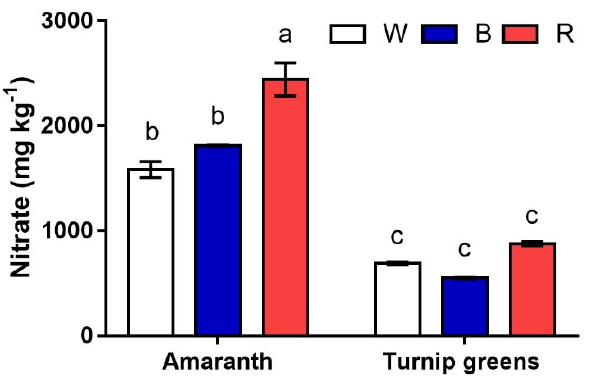
Figure 4. Interaction effect of species × light treatment (W = white, B = blue, R = red) on the nitrate content (ppm) of microgreens. Data are means ± standard error ( n = 3). Three biological replicates were used for the analysis. Different letters indicate significance at p ≤ 0.05 according to Tukey’s test.